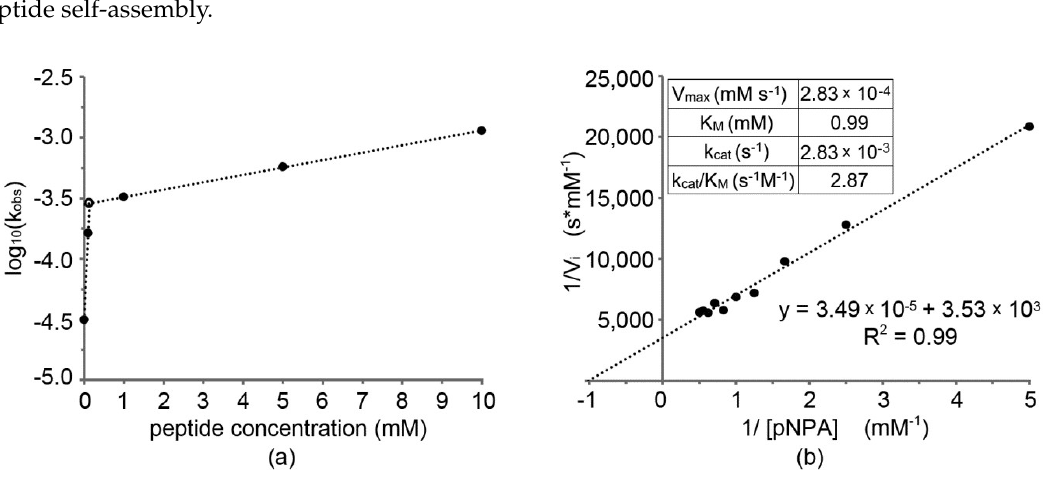
Table 1. Initial velocities (V i expressed in mM/s) at different concentrations of 4-nitrophenyl acetate (pNPA) (0.2–1.0 mM) and different concentrations of peptide catalyst (0.1, 1, 5, and 10 mM).